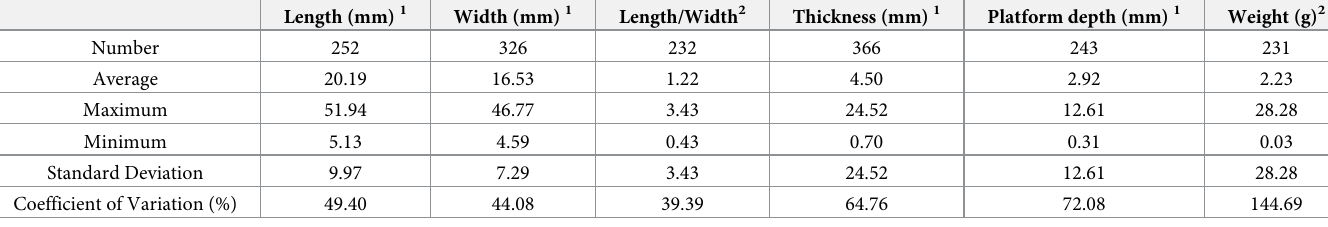
Fig 17. Bifacially-flaked chert and chalcedony tablets, Horizon IV, Saruq al-Hadid. (A) Chert tablet reduced by relatively invasive percussion flaking (images courtesy of He´l è ne David-Cuny). A burin-like blow was struck down one lateral edge from the tip, indicated by the arrow. This artefact was recovered from context 1793, but a wedge-shaped fragment with similar bifacial flaking-–probably from early in the same reduction event—was recovered from context 1790. (B) Chalcedony tablet reduced by steep, non-invasive bifacial percussion flaking, from context 1228. (C) Chalcedony tablet reduced by non-invasive bifacial percussion flaking, followed by sectioning on an anvil, from context 2448. The arrow points to a demicone on one of the truncated faces. Scale bar 50 mm. https://doi.org/10.1371/journal.pone.0270513.g017 rather than propagating down the backed face, as was likely intended, the flake instead propa- gated from the point of force application (PFA) at an angle to the backed face, breaking the segment into two pieces. The piece with the ventral surface is the perverse backing flake, and the piece with the negative scar is classified as a truncated piece if the section is irregular, or a Table 4. Dimensions of chert and chalcedony flakes, contexts 1309 and 2009, Horizon IV, Saruq